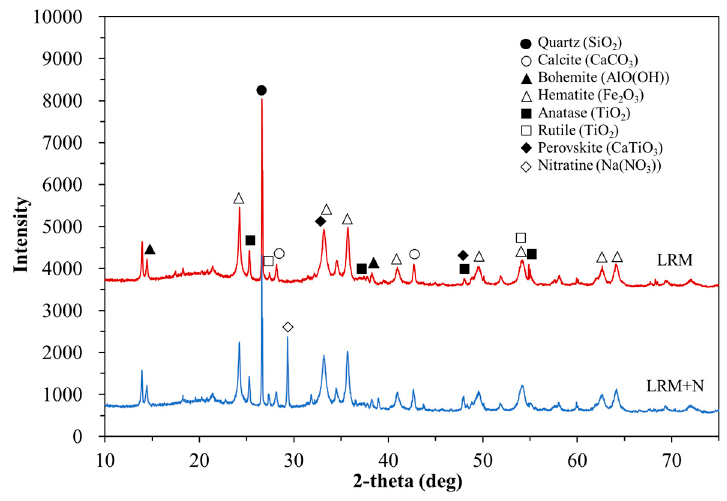
Figure 3. XRD patterns of LRM and LRM + N.